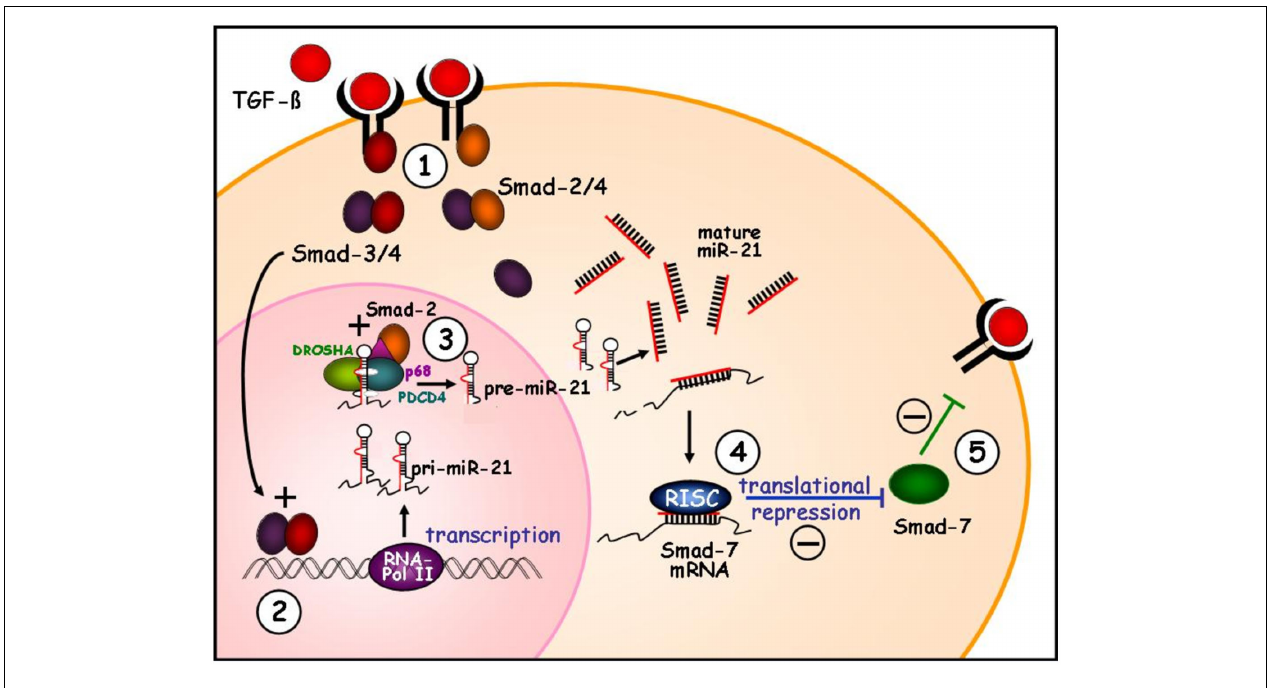
complex. AfterTGF- β exposure, both the Smad-2 and Smad-3 protein is bound by p68 of the complex resulting in stabilization and high microprocessing efficiency (3). High levels of miR-21 target the Smad-7 mRNA and repress translation of the inhibitory Smad-7 (4).The decrease of the inhibitory Smad-7 protein in turn abolishes the negative feed-back mechanisms ofTGF- β signaling (5) resulting in elevated profibrogenicTGF- β